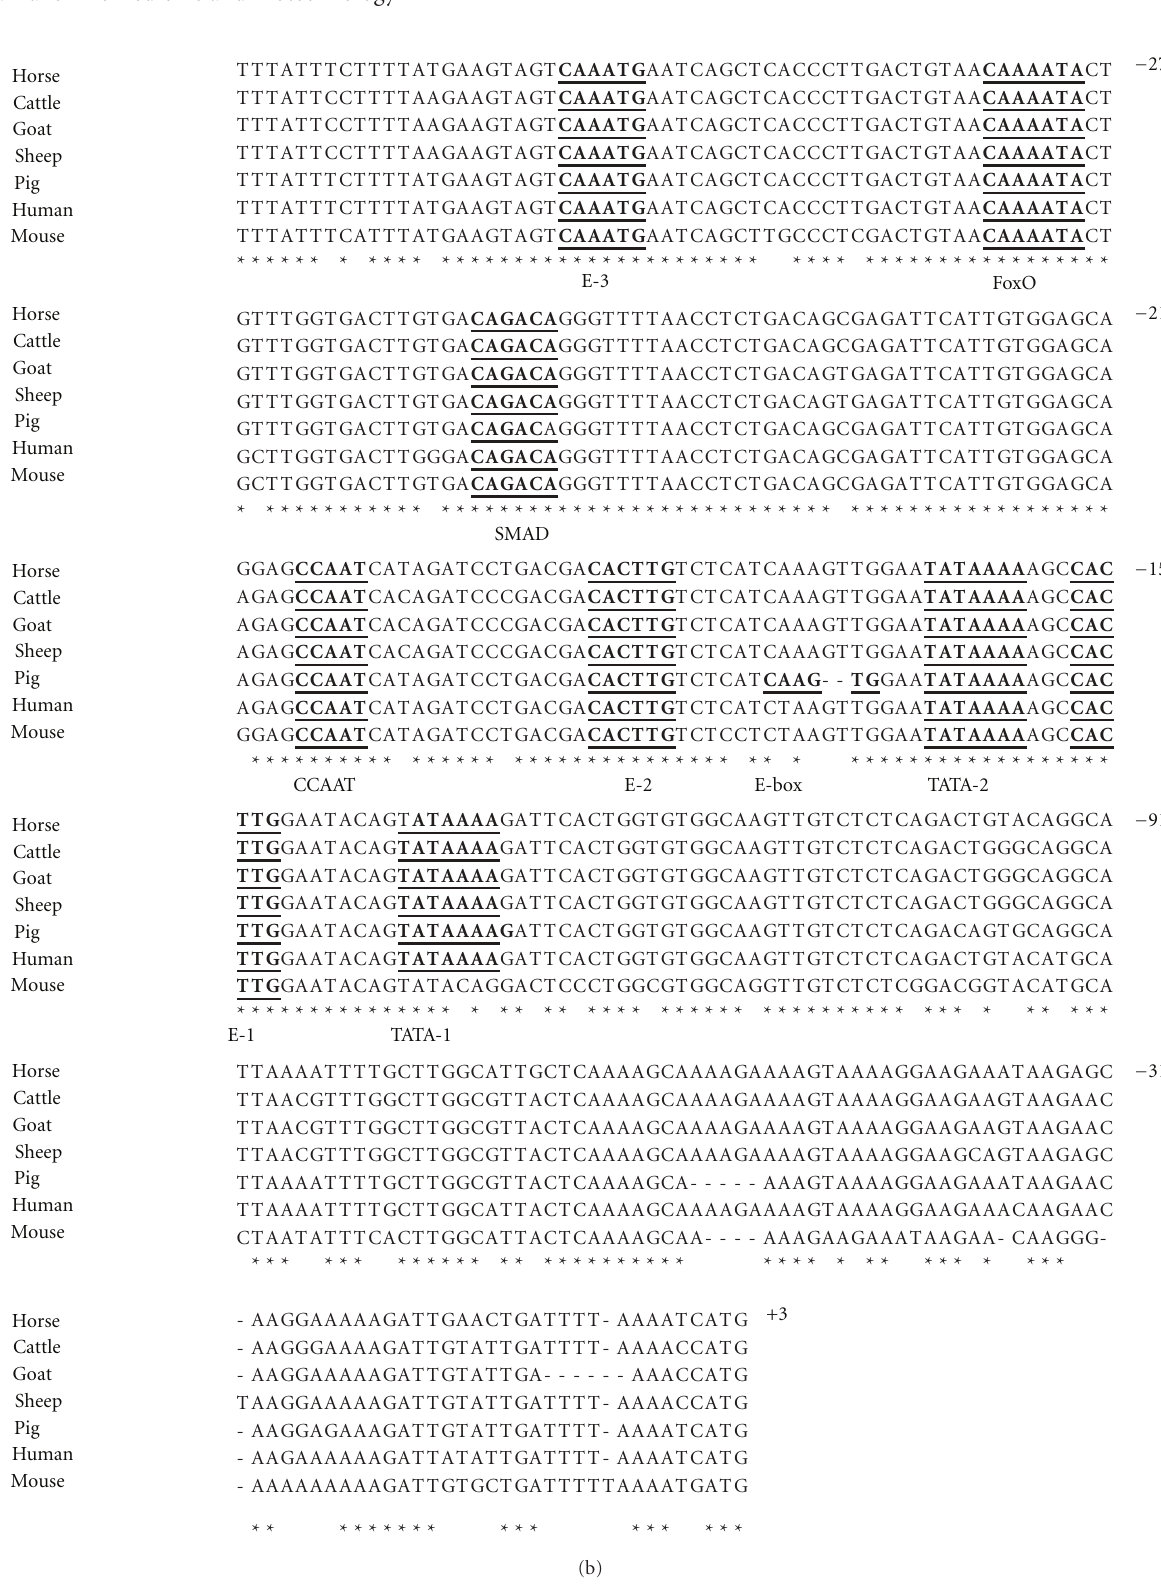
Figure 3: Sequence analysis of the proximal promoter region and 5 (cid:3) -UTR of MSTN gene. Approximately 670 bp of the MSTN 5 (cid:3) -flanking region and 5 (cid:3) -UTR from horse, cattle, goat, human, mouse, pig, and sheep is shown. The consensus for transcription factor binding motives is shown in bold text and underlined. Numbering of the horse sequence is relative to the ATG start codon. Numbering of E-boxes is relative to the horse sequence. The two identified SNPs of horse MSTN gene are indicated with Y (T or C according to the IUPAC nomenclature) and in